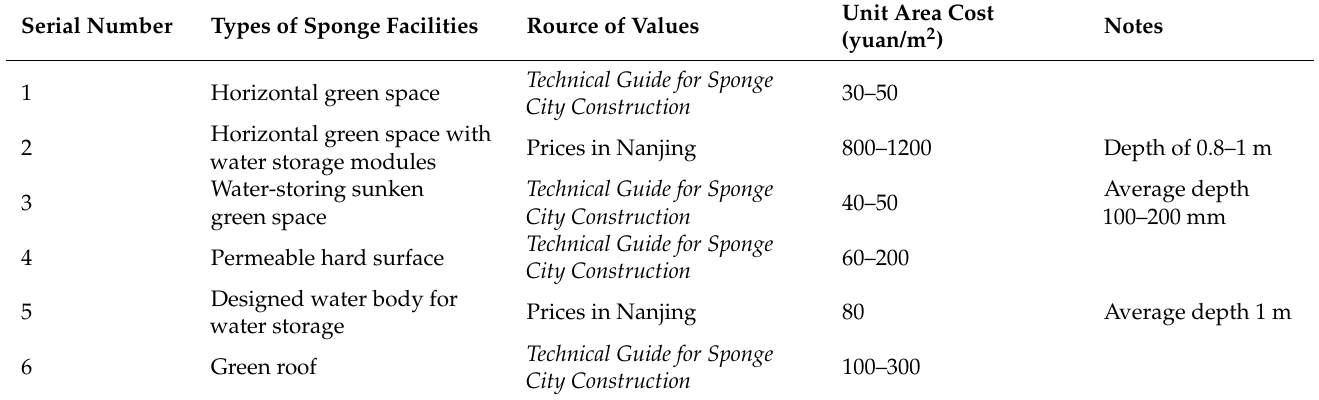
Table A5. Reference unit cost for different types of sponge